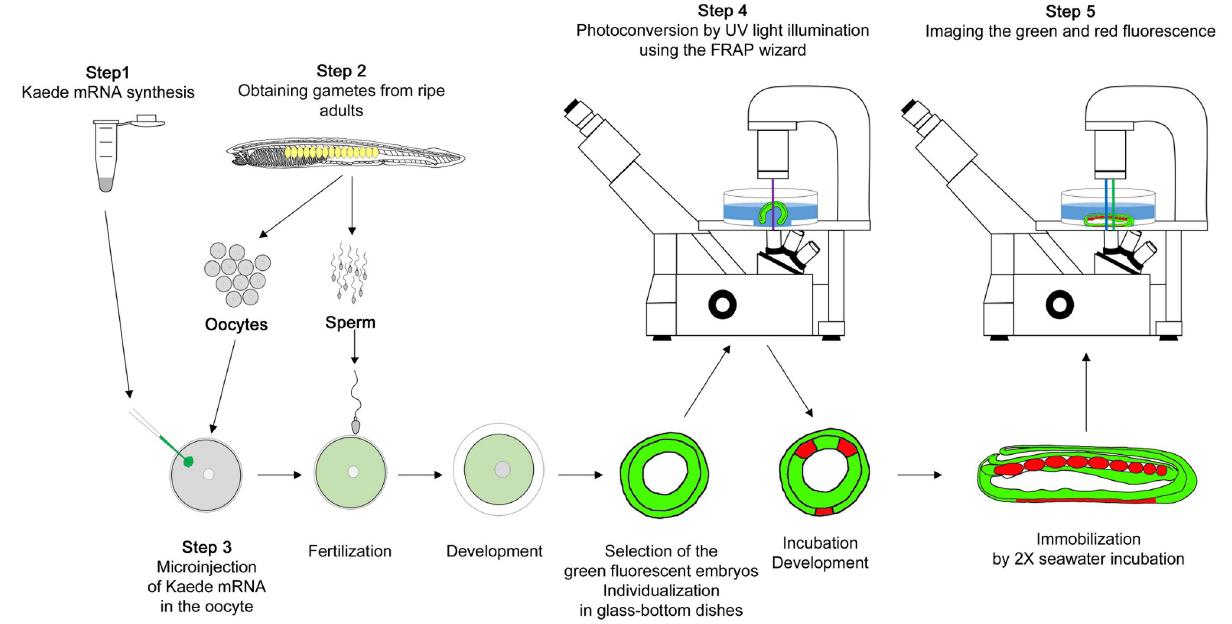
Fig 1. Main steps for cell tracking using Kaede photoconversion in amphioxus